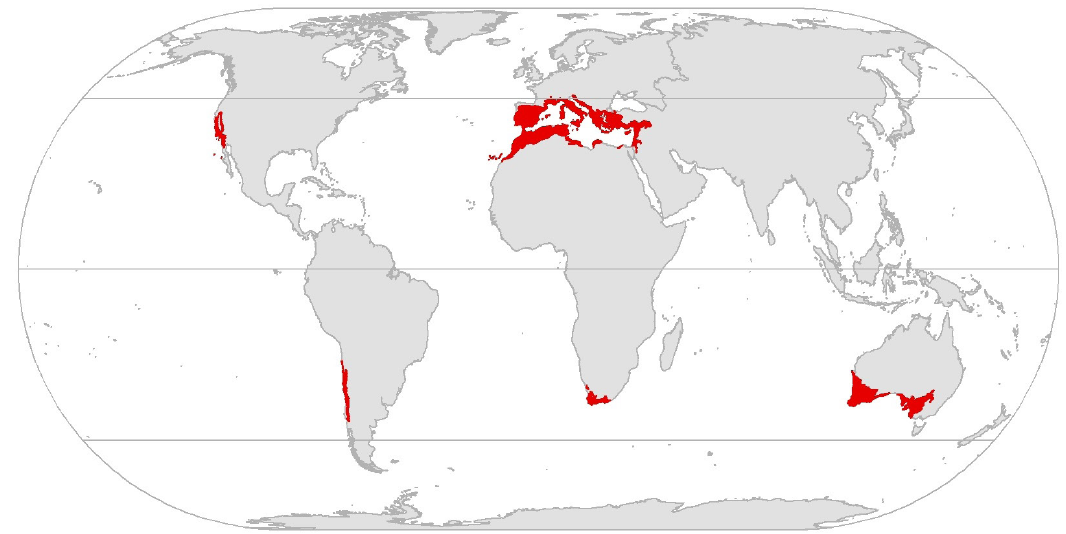
Figure 1. Mediterranean biomes of the world encompassing the Mediterranean Forests, Woodlands, and Scrub terrestrial ecoregions defined by the WWF (www.worldwildlife.org). Map uses Eckert IV projection. Latitudinal lines are placed at 45 degrees above and below the